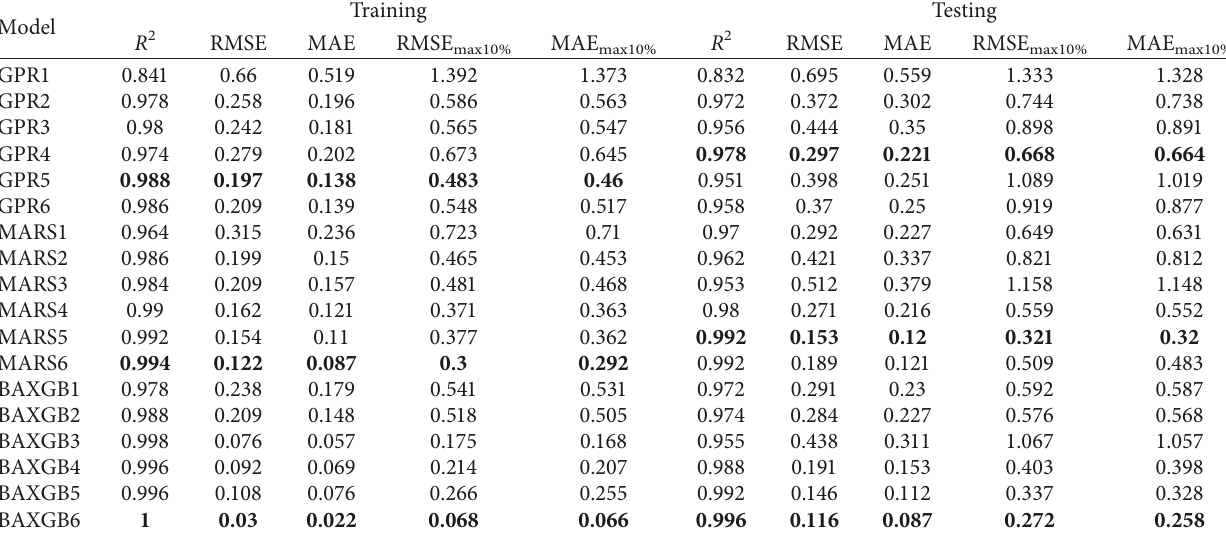
Table 4: Results of the statistical indicators for all models in the Datong station during the training and testing stages. Training Model